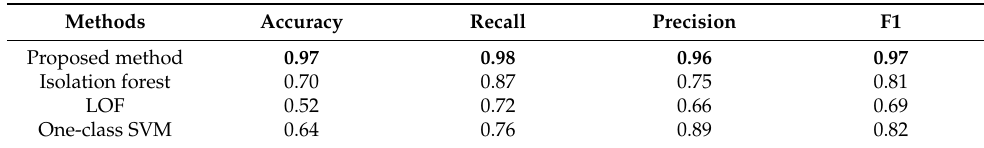
Table 6. Fault detection performance